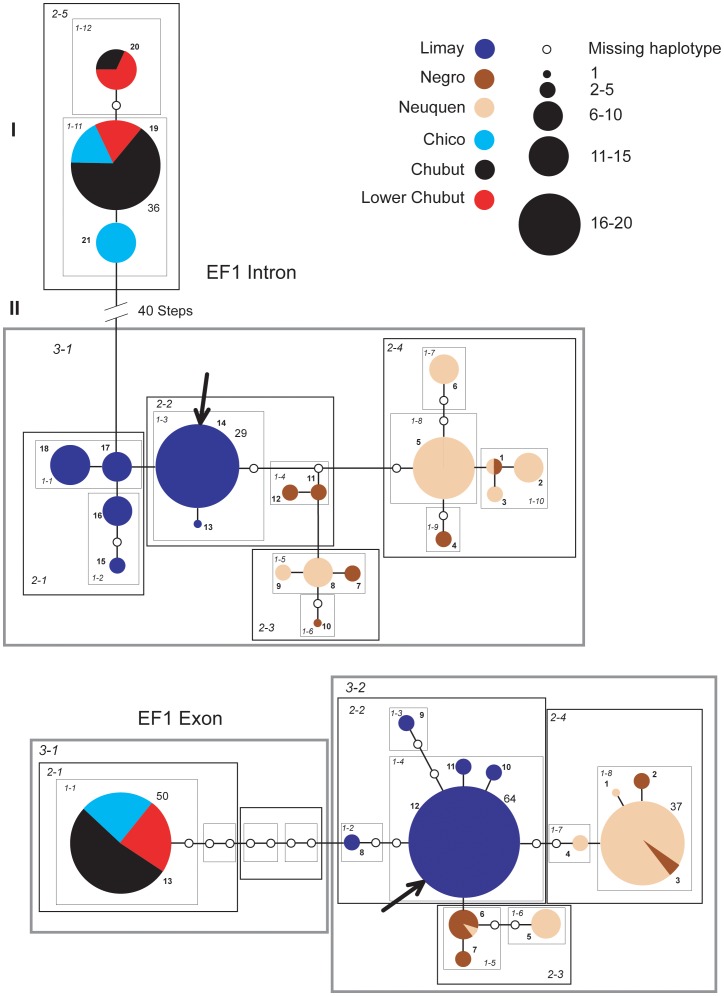
Haplotype networks with nested clade design for the nuclear EF1α intron and exon.Haplotype circle size is proportional to its frequency. Each haplotypes is numbered. Haplotypes that exceed twenty individuals are labeled with the total number of individuals of that haplotype. Arrow indicates the root haplotype. Black empty circles represent extinct (or unsampled) haplotypes. Color codes indicate the six major rivers.